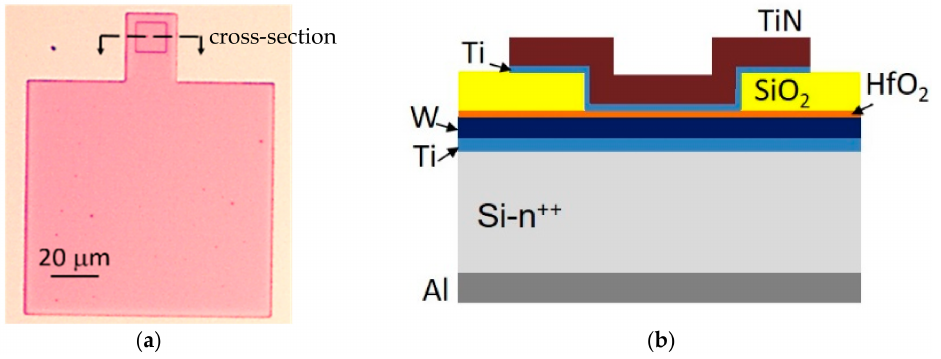
Figure 1. ( a ) Top-view optical microscope image. ( b ) Schematic device cross-section pinpointed in ( a